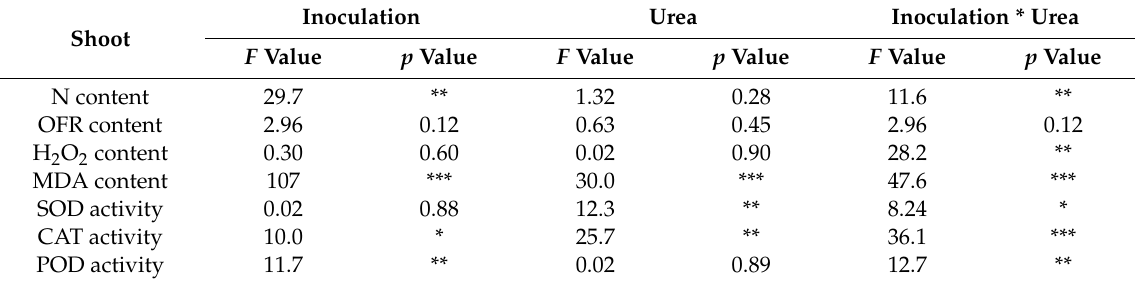
Table 4. The significance of the urea and rhizobium treatments (and interaction) on plant shoots. Inoculation Urea Inoculation * Urea Shoot F Value